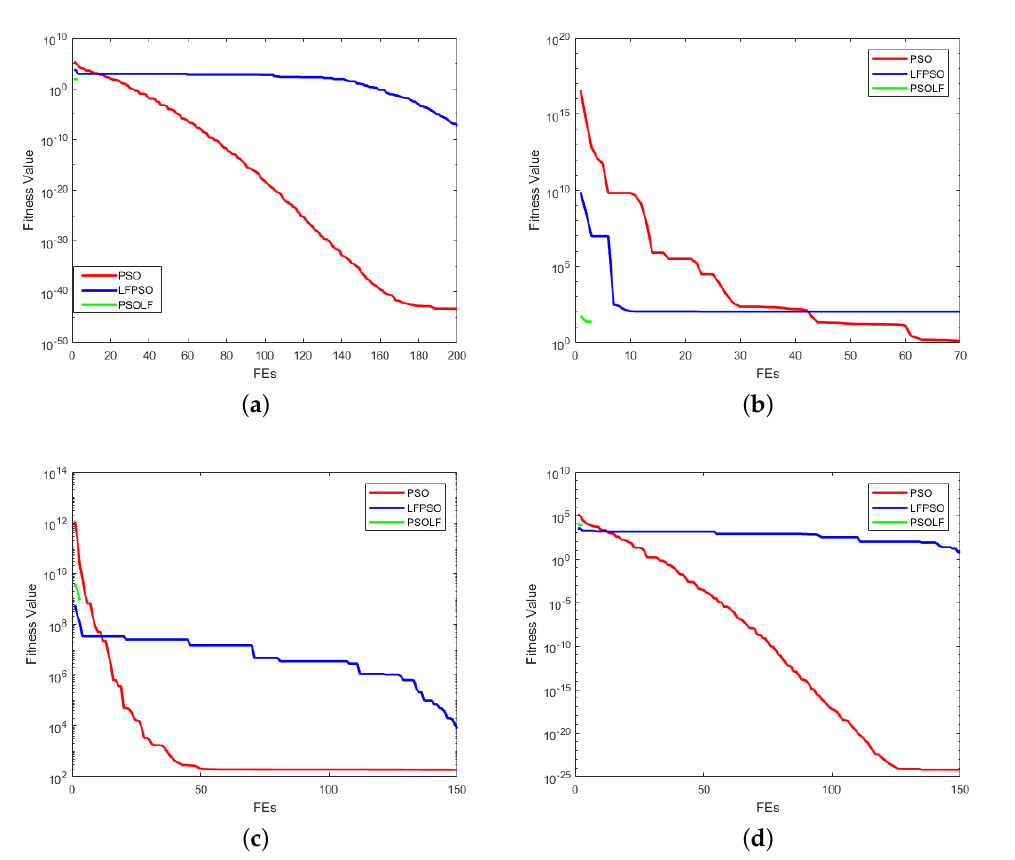
Figure 8. Unimodal Functions. ( a ) SPHERE; ( b ) SCHWEFEL 2.22; ( c ) ROSENBROCK; ( d ) NOISE.